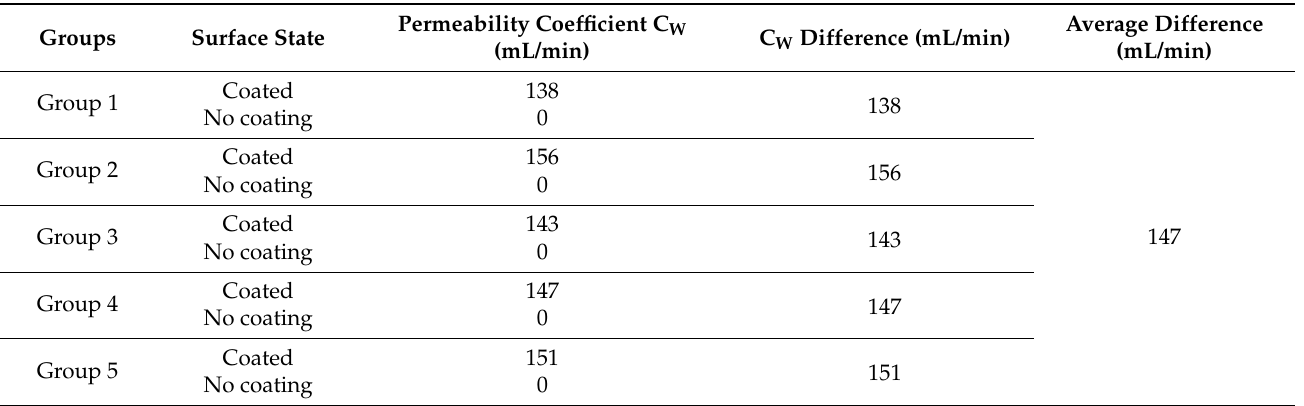
Table 14. Results of water permeability